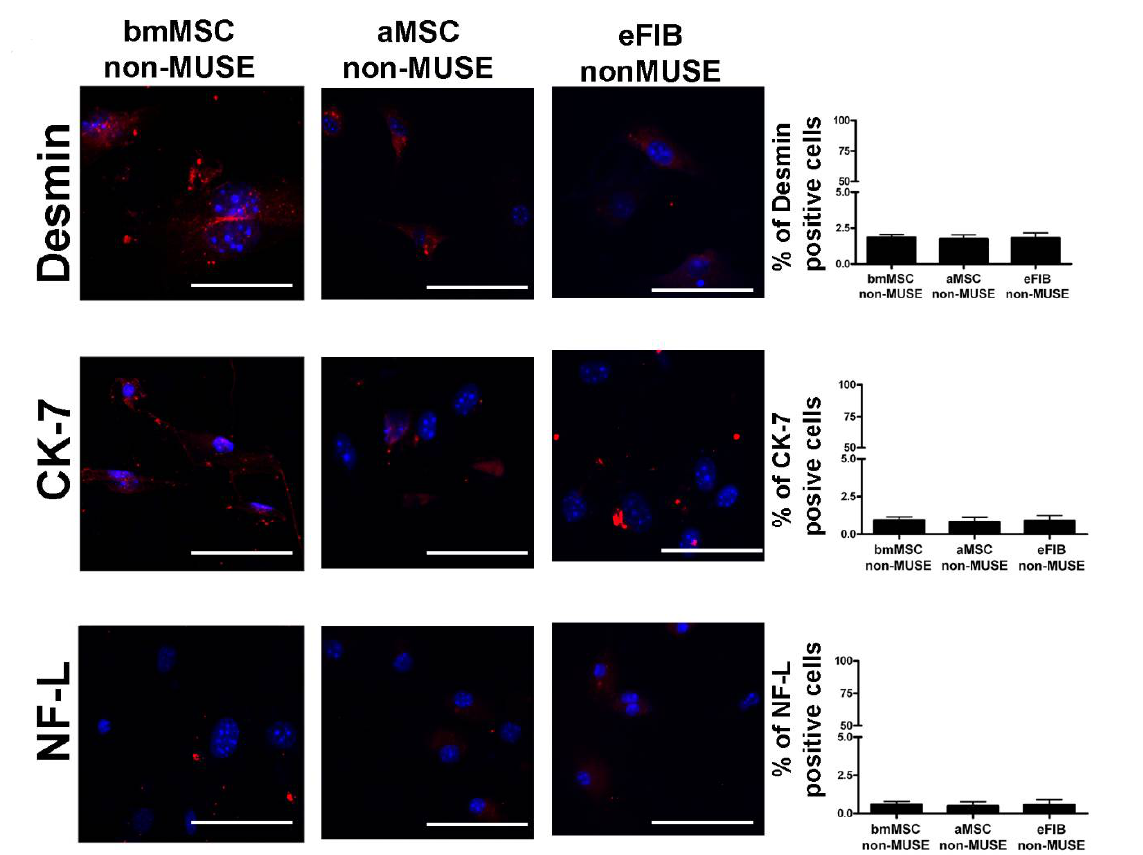
Figure 7. Representative picture of ICC staining after spontaneous differentiation of non-MUSE cells. Desmin (red) was used as a mesodermal marker. CK-7 (red) was used as endodermal marker. NF-L (red) was used as ectodermal marker. The nuclei were counterstained with DAPI (blue). The histograms show the percentage of desmin, CK-7, and NF-L positive cells. The data are expressed with standard deviation ( n = 5).